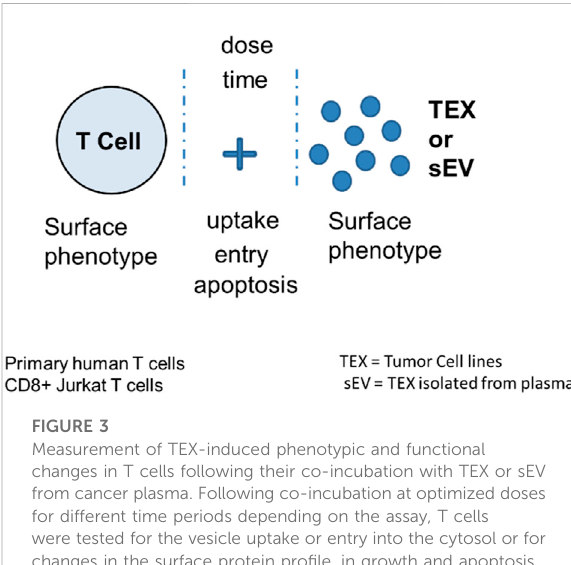
Measurement of TEX-induced phenotypic and functional changes in T cells following their co-incubation with TEX or sEV from cancer plasma. Following co-incubation at optimized doses for different time periods depending on the assay, T cells were tested for the vesicle uptake or entry into the cytosol or for changes in the surface protein pro fi le, in growth and apoptosis levels or in mRNA transcription. Vertical stipled lines indicate that inhibitors of the T cell-TEX crosstalk can be used to block T cell- TEX interactions.